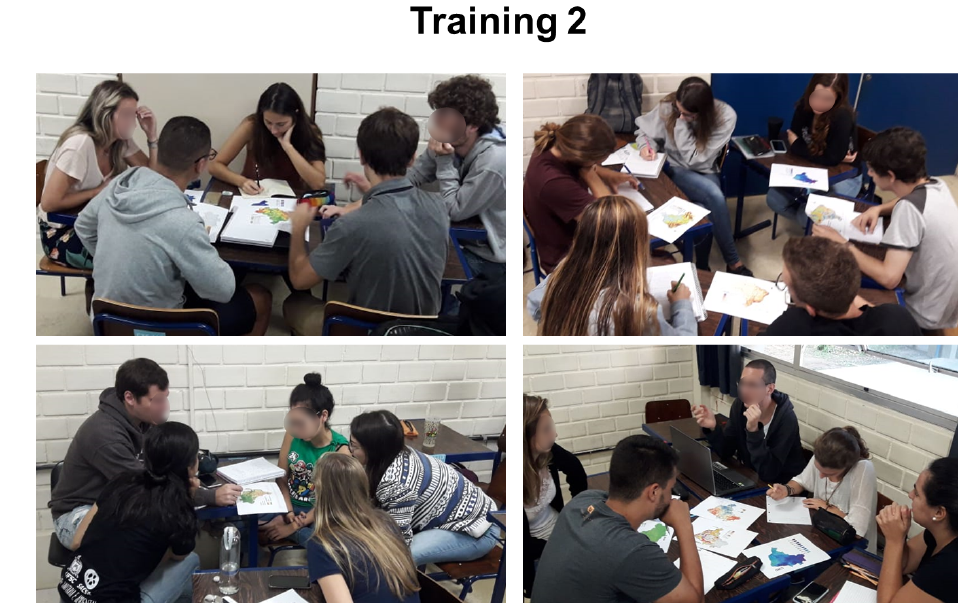
Figure A9. Photos of the groups working on the activities of the second